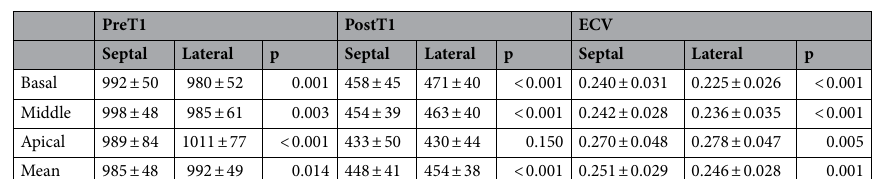
Figure 1. Mean segmental pre-contrast T1 value and mean extracellular volume fraction (ECV) of the left ventricle (LV). (A) Total study population. ( B ) Male. ( C) Female. Pre-contrast T1 value and ECV were significantly higher in women than in men in global LV segments ( p < 0.05) except apical inferior segment.